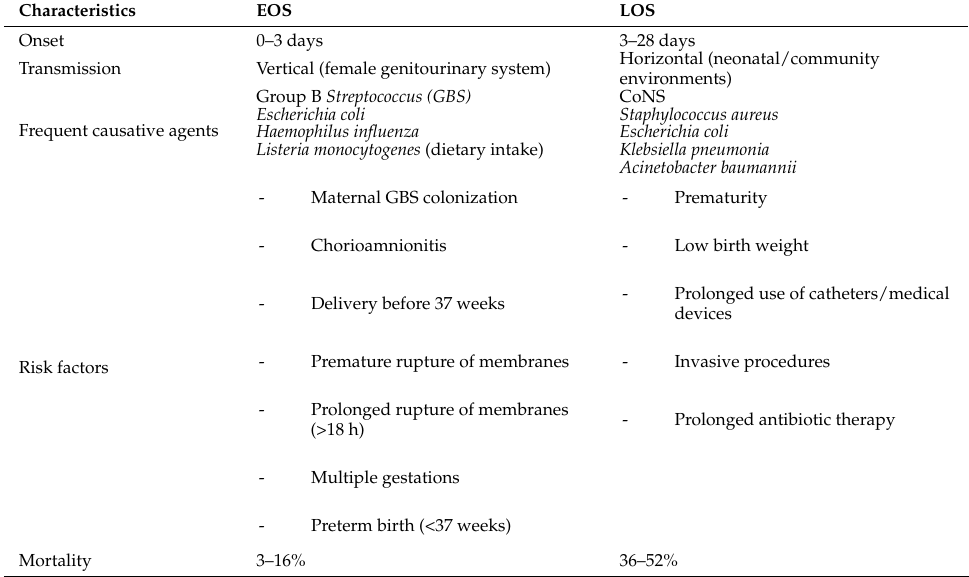
Table 1. Compilation of the differences that can be found between EOS and LOS [12,16–20].